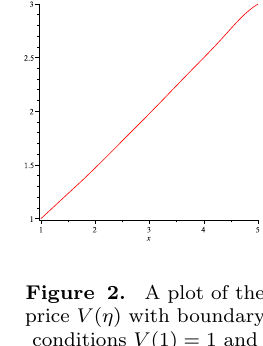
Figure 2. A plot of the price V ( η ) with boundary conditions V (1) = 1 and V (5) = 3.